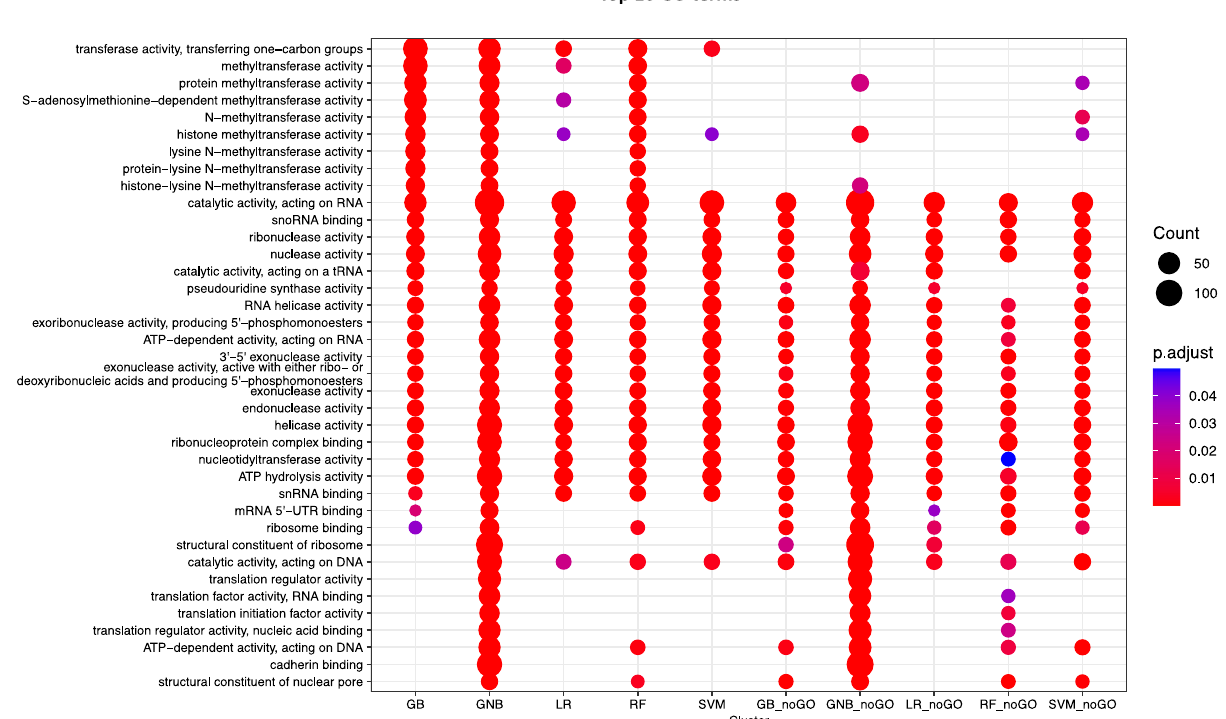
Fig. 3 Functional enrichment analyses of high-con fi dence predictions. Comparing GO enrichment results of genes in the top 1% of the probability distribution for Class 1 for each model ensemble. The top enriched terms include functions such as RNA-binding and RNA catalytic activities. For models trained on the full feature set, predictions were also associated with chromatin and protein methylation